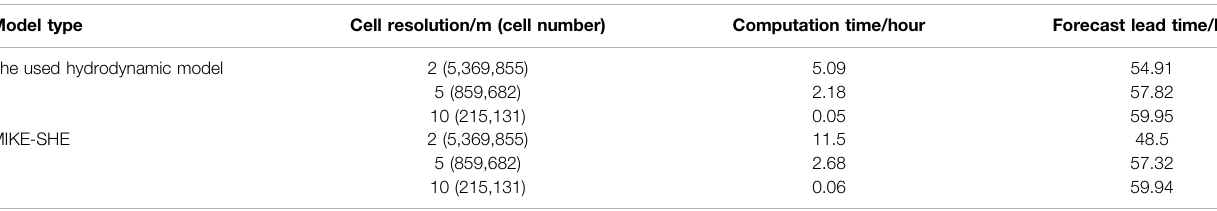
TABLE 5 | Runtime for 12 h of fl ood simulations at different spatial resolutions.